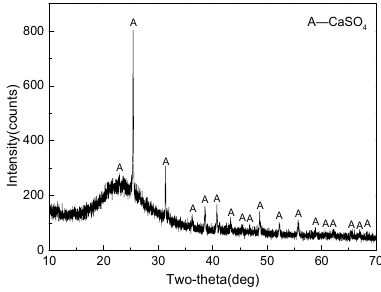
Figure 5. X-ray diffraction (XRD) pattern of acid leaching residue.